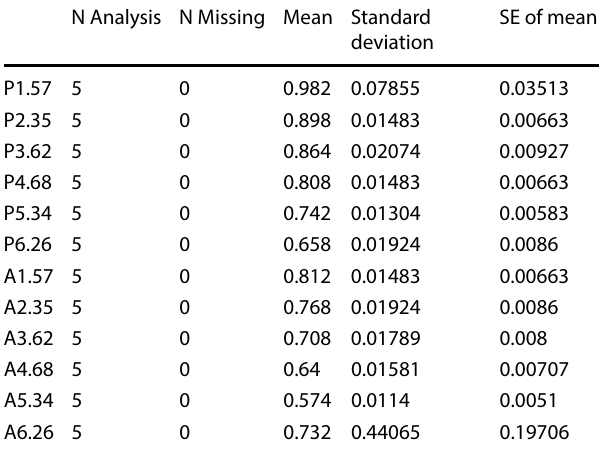
Table 19 Levine’s test (Absolute deviations)